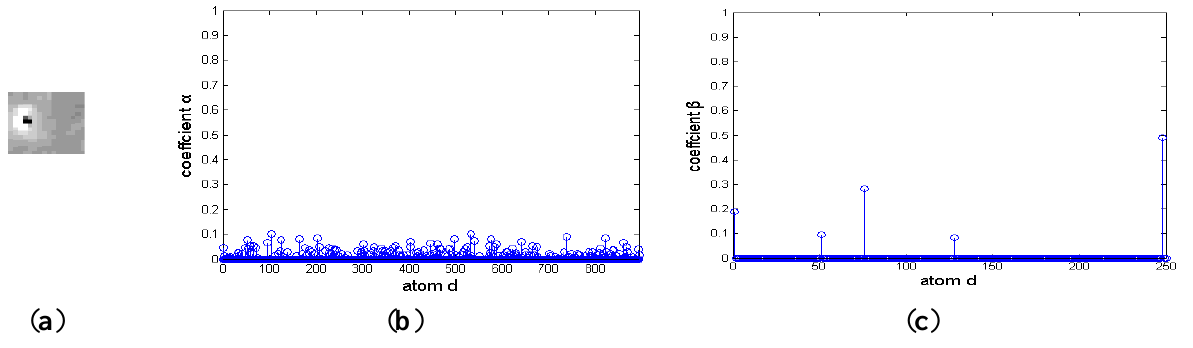
Figure 11. Representation coefficient of target signal in deep space image decomposed on discriminative over-complete dictionary. ( a ) Target signal. ( b ) Sparse coefficient on background dictionary. ( c ) Sparse coefficient on target dictionary.